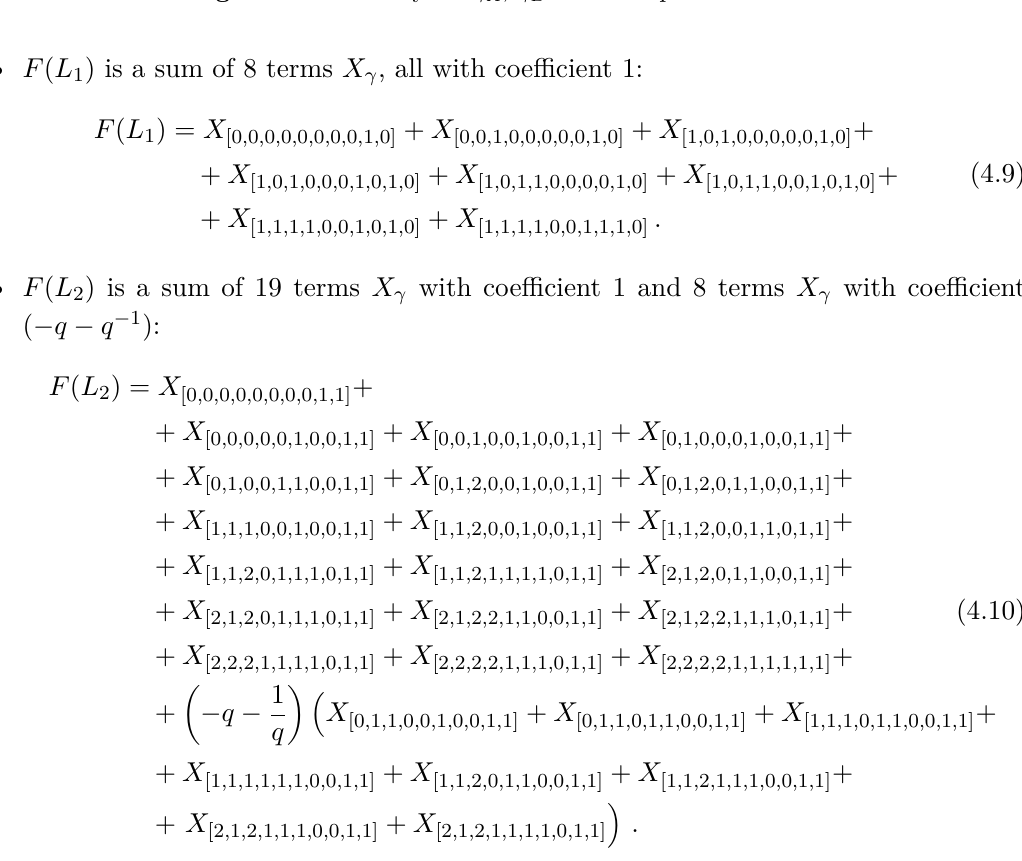
Figure 47 . Two 1 -cycles γ A , γ B on the triple cover e C